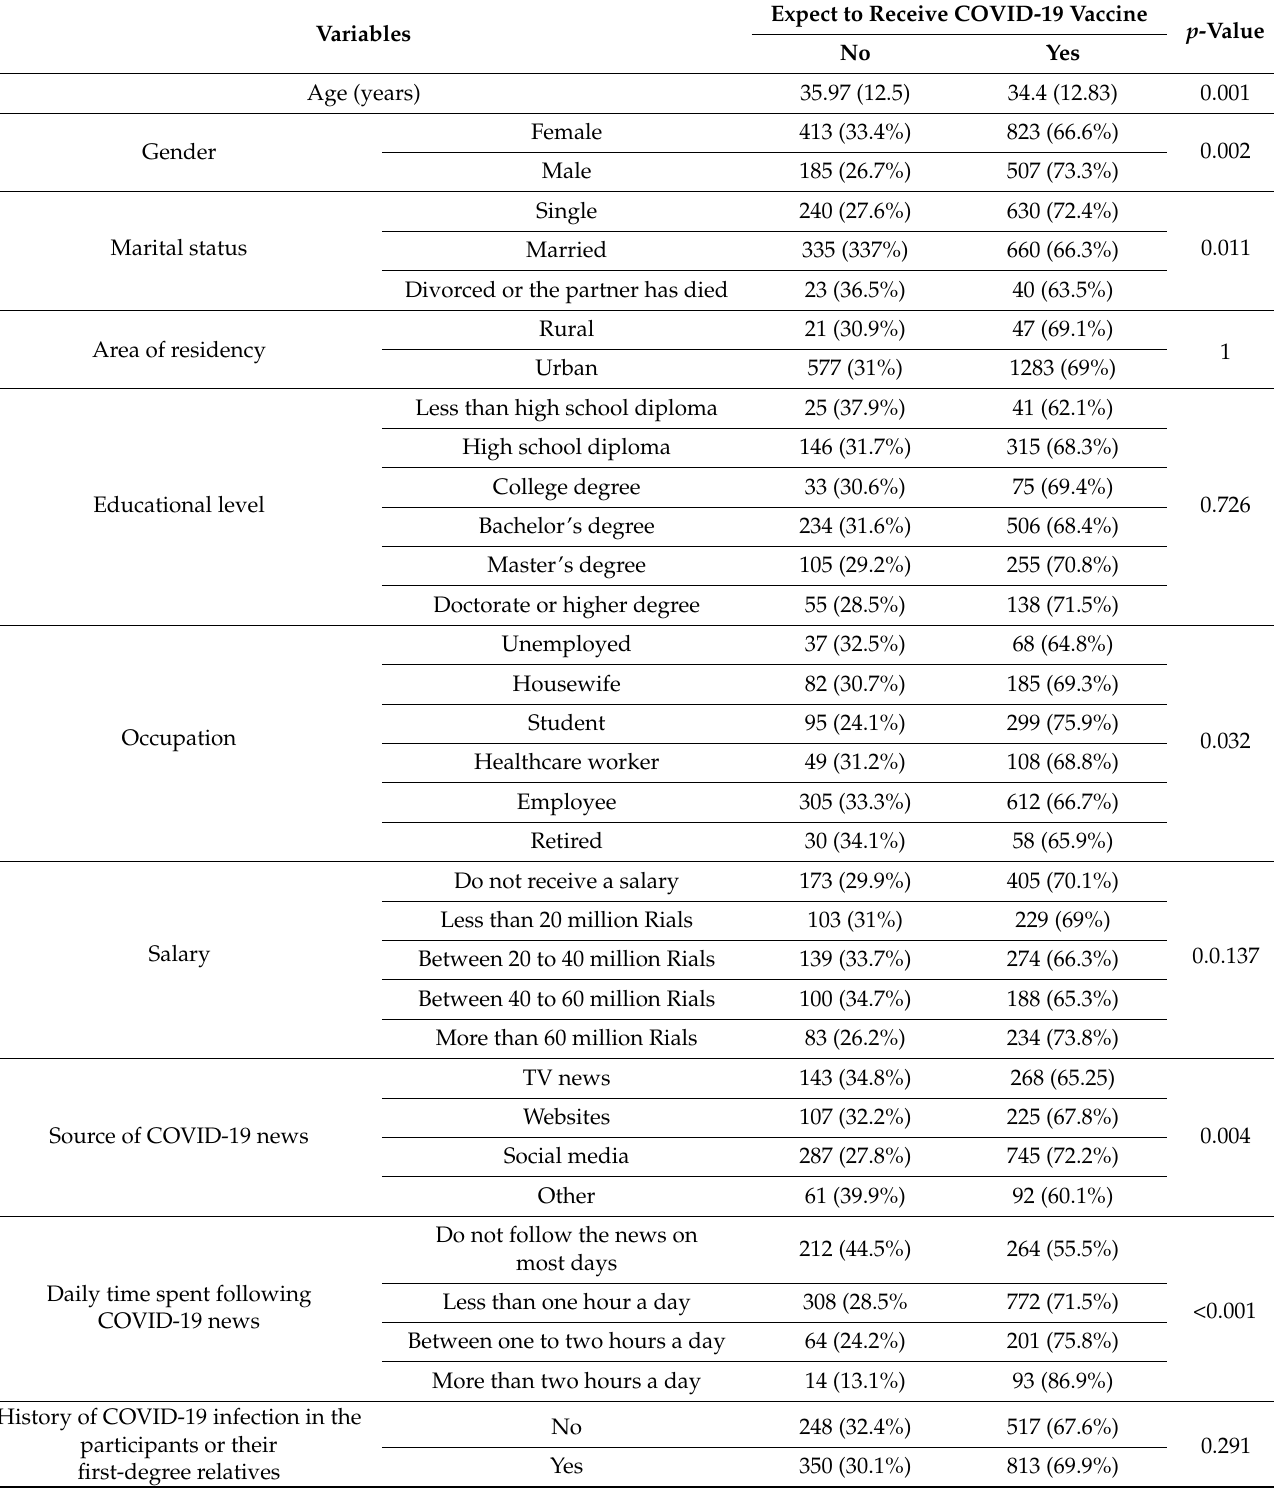
Table 4. Association between participants’ desire to receive the COVID-19 vaccine and basic charac- teristics, their attitude, confidence, and concerns about the COVID-19